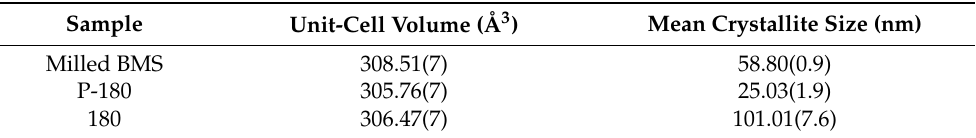
Figure 3. XRPD patterns of ( a ) milled BMS precursor, and ( b ) P-180 and ( c ) 180 powders, with the corresponding Le Bail refinements. Experimental pattern (black), calculated pattern (red) and difference plot (blue). Gray vertical bars correspond to IH-SS, PDF 01-070-8143. Table 2. Unit-cell volumes and mean crystallite sizes of the phases within ilmenite-hematite solid solution for milled BMS, and P-180 and 180